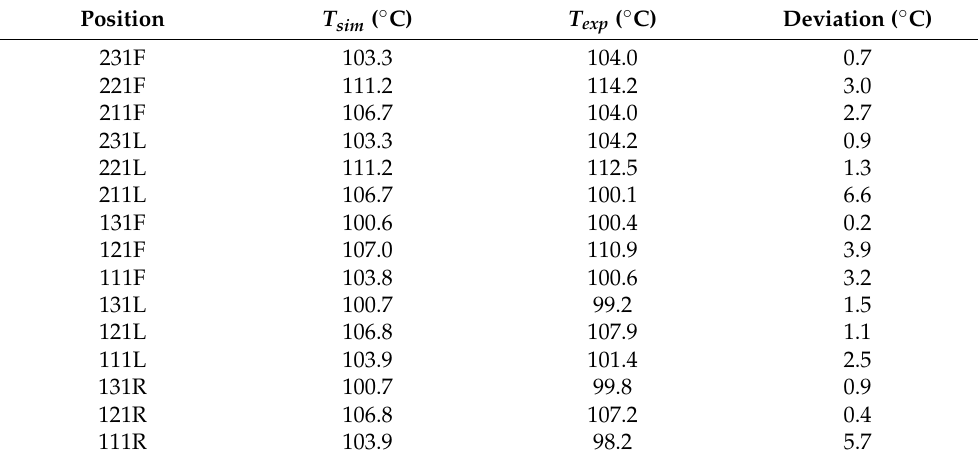
Table 3. Temperature values under steady-state conditions for different points in the transformer. Comparison between experimental and numerical